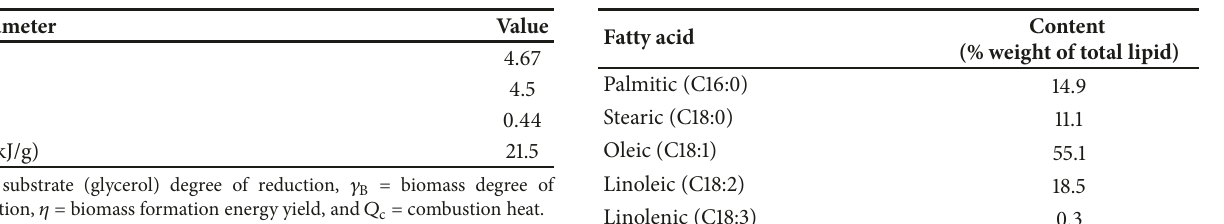
Table 2: Calculated parameters for energy balance. Table 3: Oil fatty acid